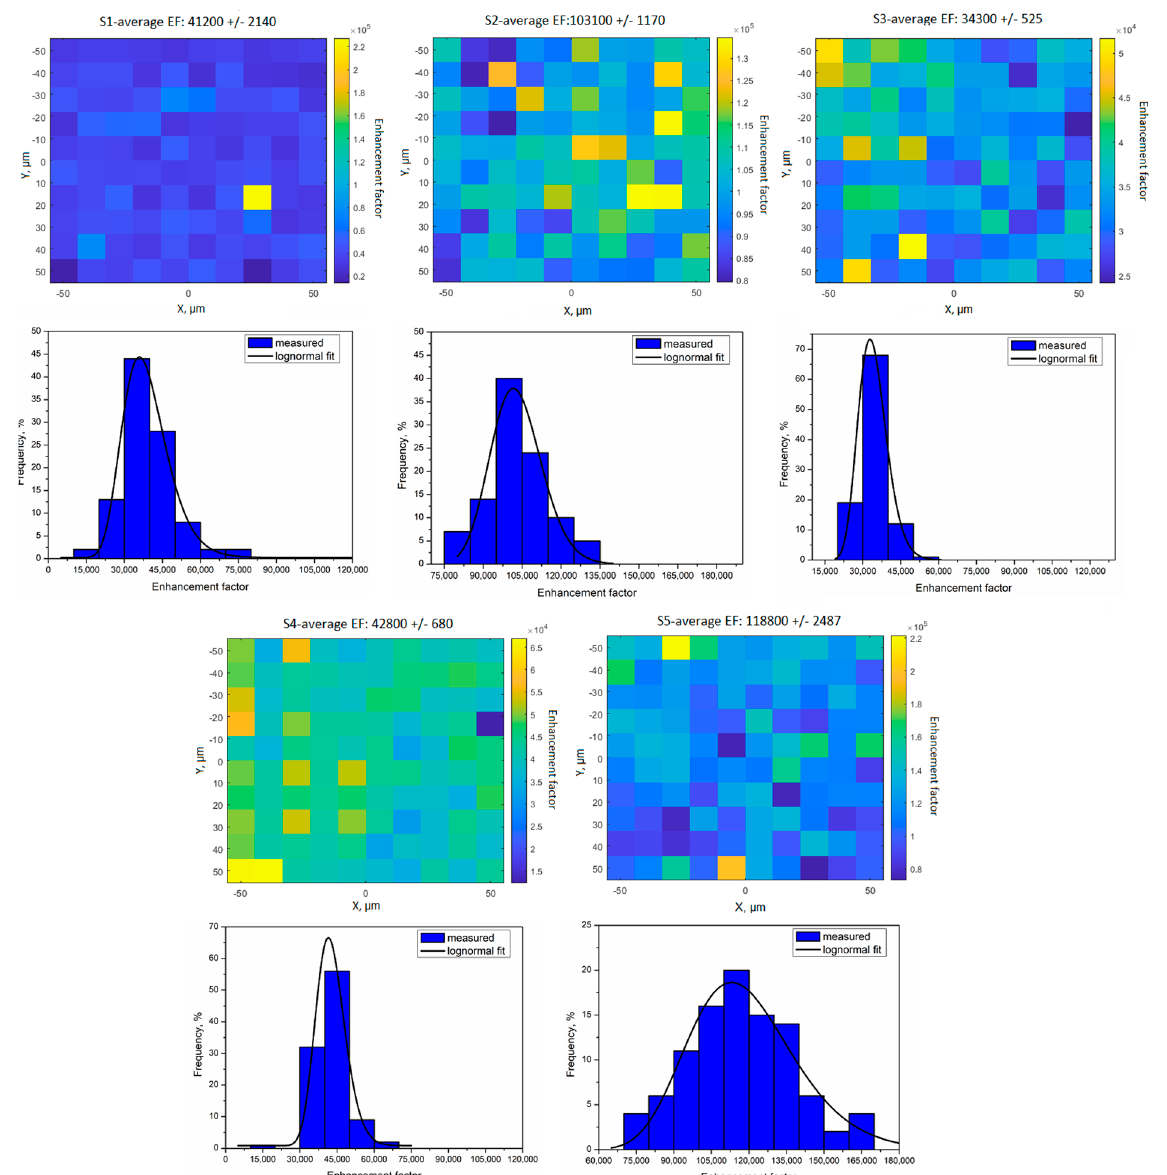
Figure 7. Enhancement maps and the corresponding distributions. Table 5. Average enhancement factor and the (relative) standard deviation derived from enhancement maps of S1–S5.